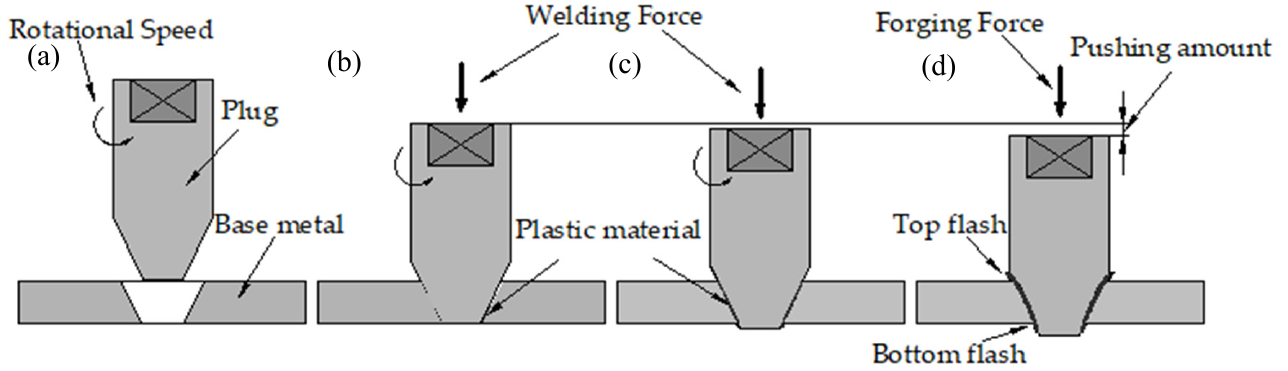
Figure 2. Schematic illustration of FPW process: ( a ) the plug move toward the plate hole, ( b ) the plug